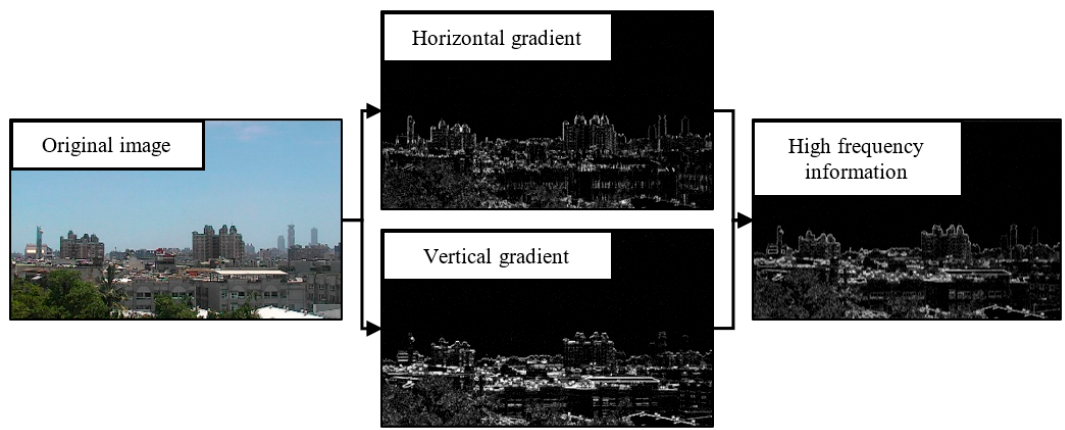
Figure 6. The image performs horizontal and vertical gradient calculations and calculates the high-frequency information.